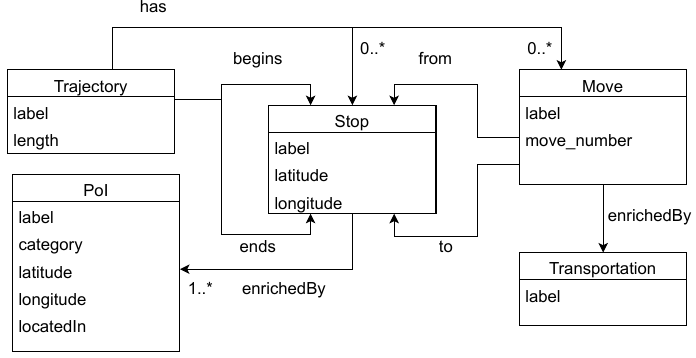
Figure 4. Representation of the TripBuilder dataset.